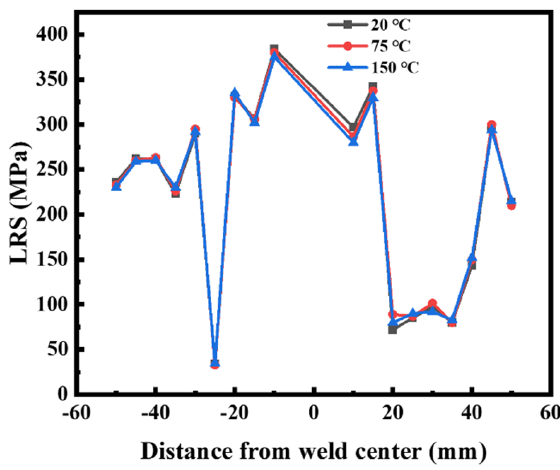
Figure 13. Residual stress distribution of single heat treatment.